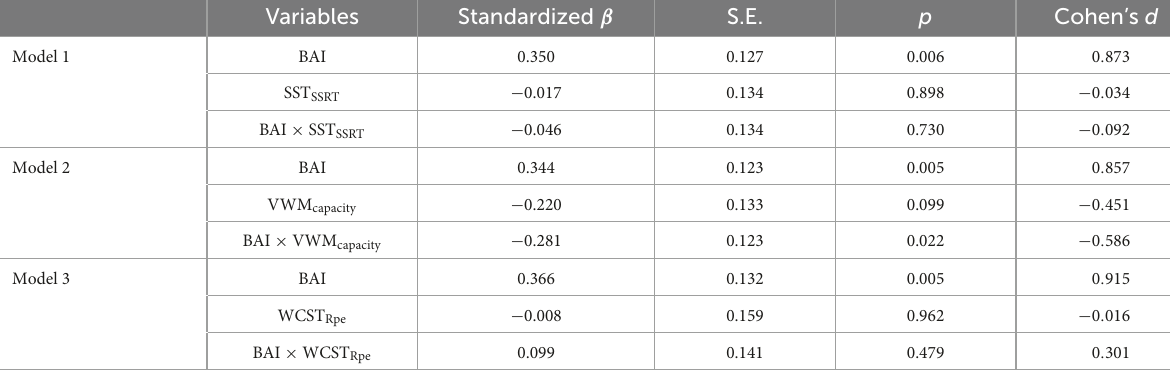
TABLE 5 The moderating effect of executive function on anxiety and checking